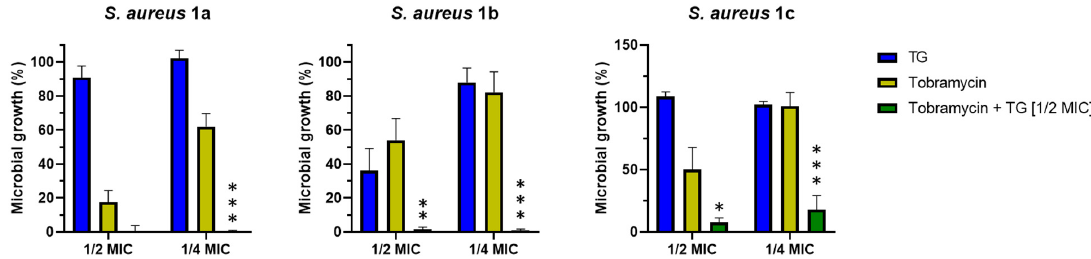
Figure 4. Effect of TG when used alone or in combination with tobramycin at its ½ and ¼ MIC on the growth of the three clinical isolates S. aureus 1a, 1b, and 1c after 20 h of peptide treatment. Values are the mean of three independent experiments run in triplicate ± S.E.M. Statistical significance between tobramycin and tobramycin plus TG (1/2 MIC) was reported as follows: * p < 0.05; ** p < 0.01; *** p < 0.001